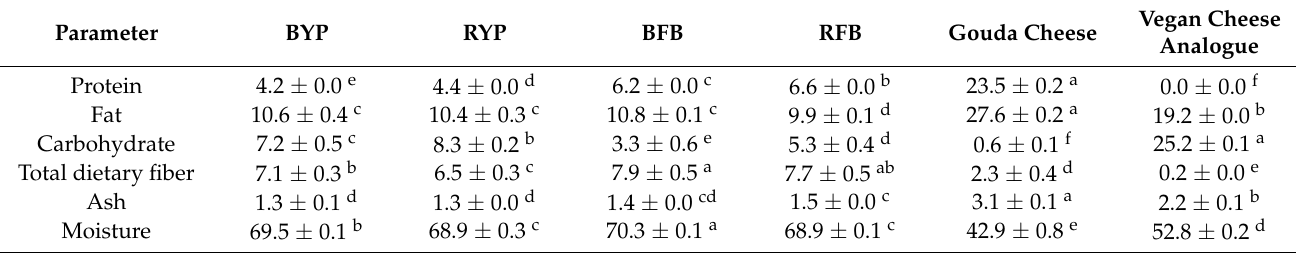
Table 4. The proximate composition 1 of pulse-based cheese analogues and reference products. Parameter BYP